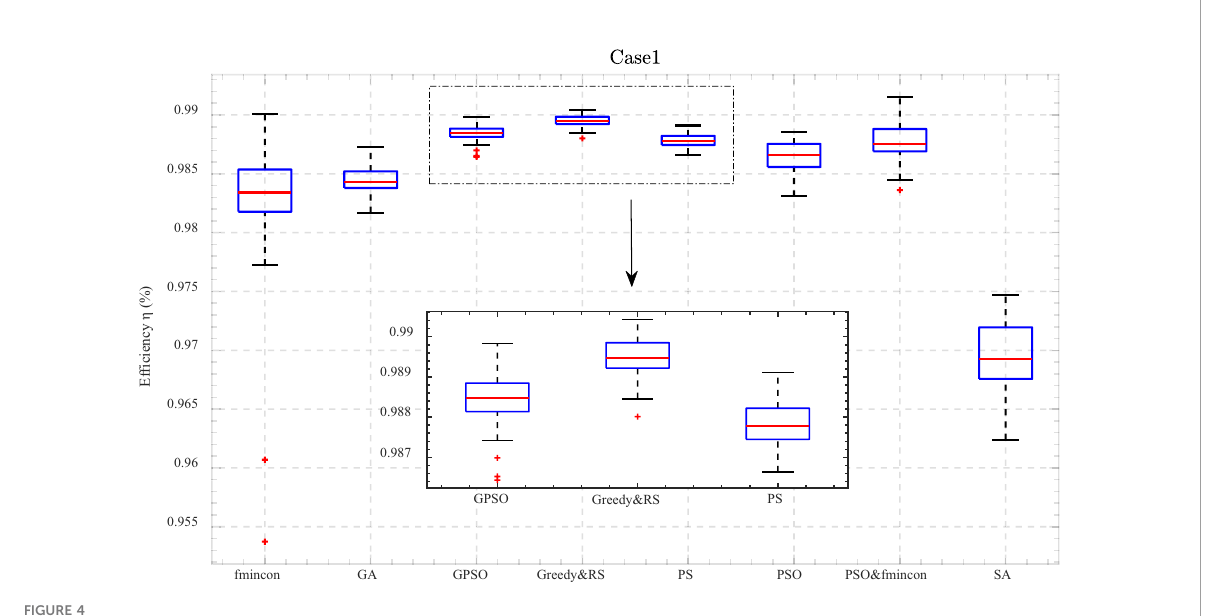
FIGURE 4 Boxplot of wind farm ef fi ciency using different optimization